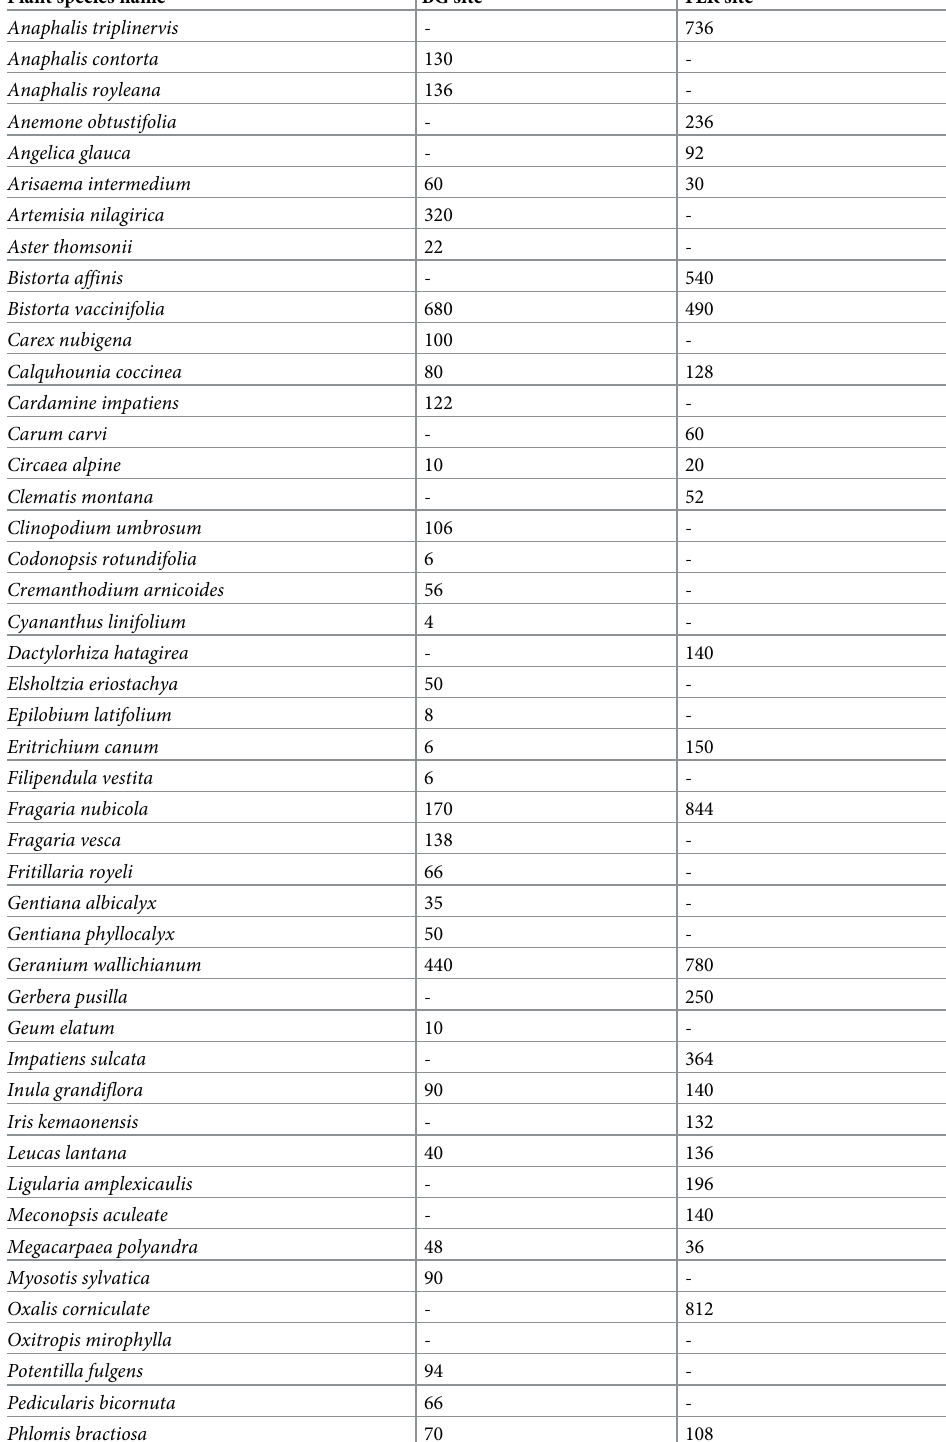
Table 4. Density (Ind.m -2 ) of herbaceous species at BG and TLR sites around the temperate region of Nanda Devi Biosphere Reserve, Western